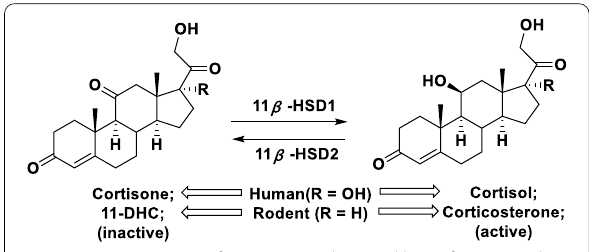
Fig. 1 Interconversion of cortisone and cortisol by 11 β ‑HSD1 and 11 β ‑HSD2 in humans and 11‑dihydrocorticosterone (11‑DHC) and corticosterone in